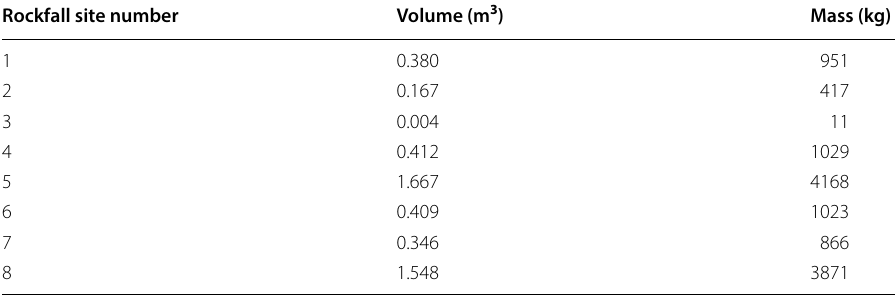
Table 1 Block volume and corresponding mass at each rockfall site Rockfall site number